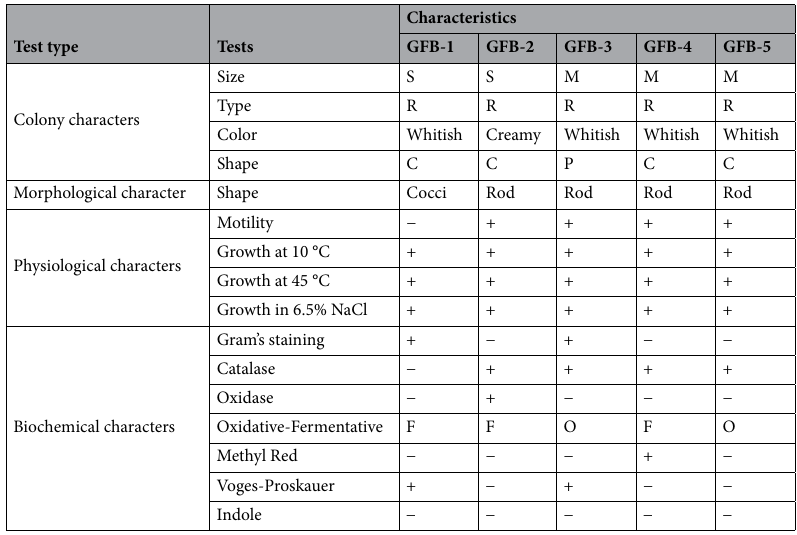
Table 1. Morphological, physiological and biochemical characters of probiotic isolates collected from B. gonionotus gut. S, small; M, medium; R, round; C, convex; P, Plain; O, oxidative; F, fermentative; +, positive; −, negative.